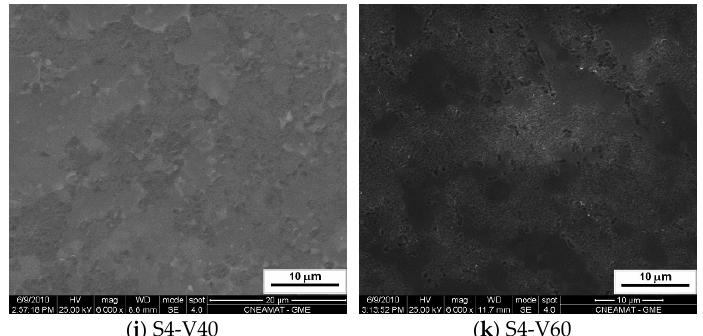
Figure 3. SEM micrographs of anodic oxidized samples.